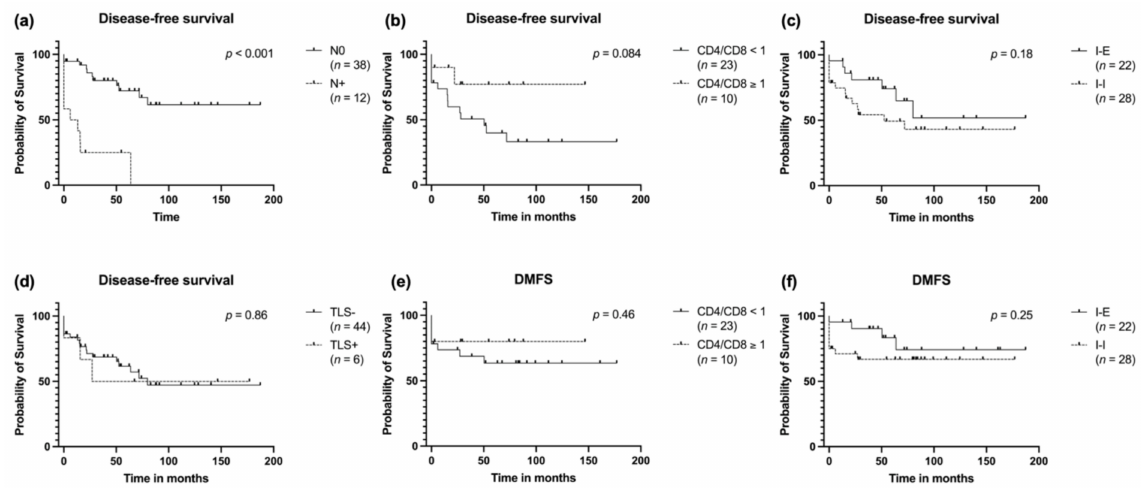
Figure 5. Disease-free survival stratified to ( a ) T stage, ( b ) CD4/CD8 T cell ratio, ( c ) spatial distribu- tion of TIL and ( d ) presence of TLS. Distant metastases free survival stratified to ( e ) CD4/CD8 T cell ratio and ( f ) spatial distribution pattern of